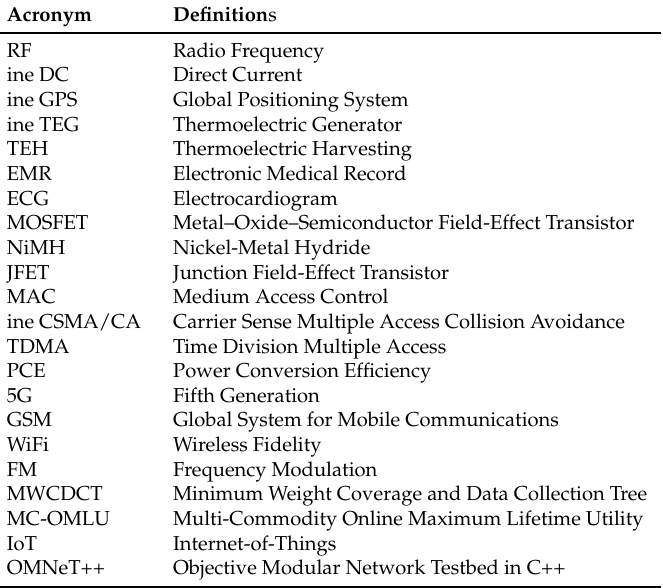
Table 1. Acronyms and their definitions used in this